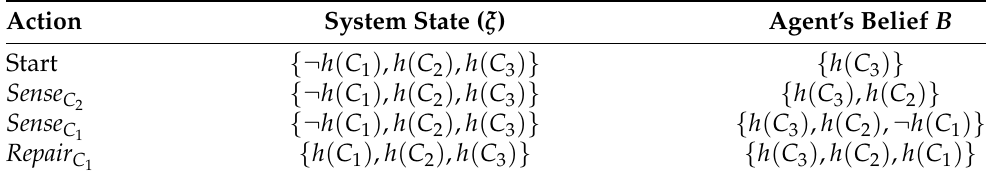
Table 1. An example of a system state and an agent’s beliefs affected by the troubleshooting